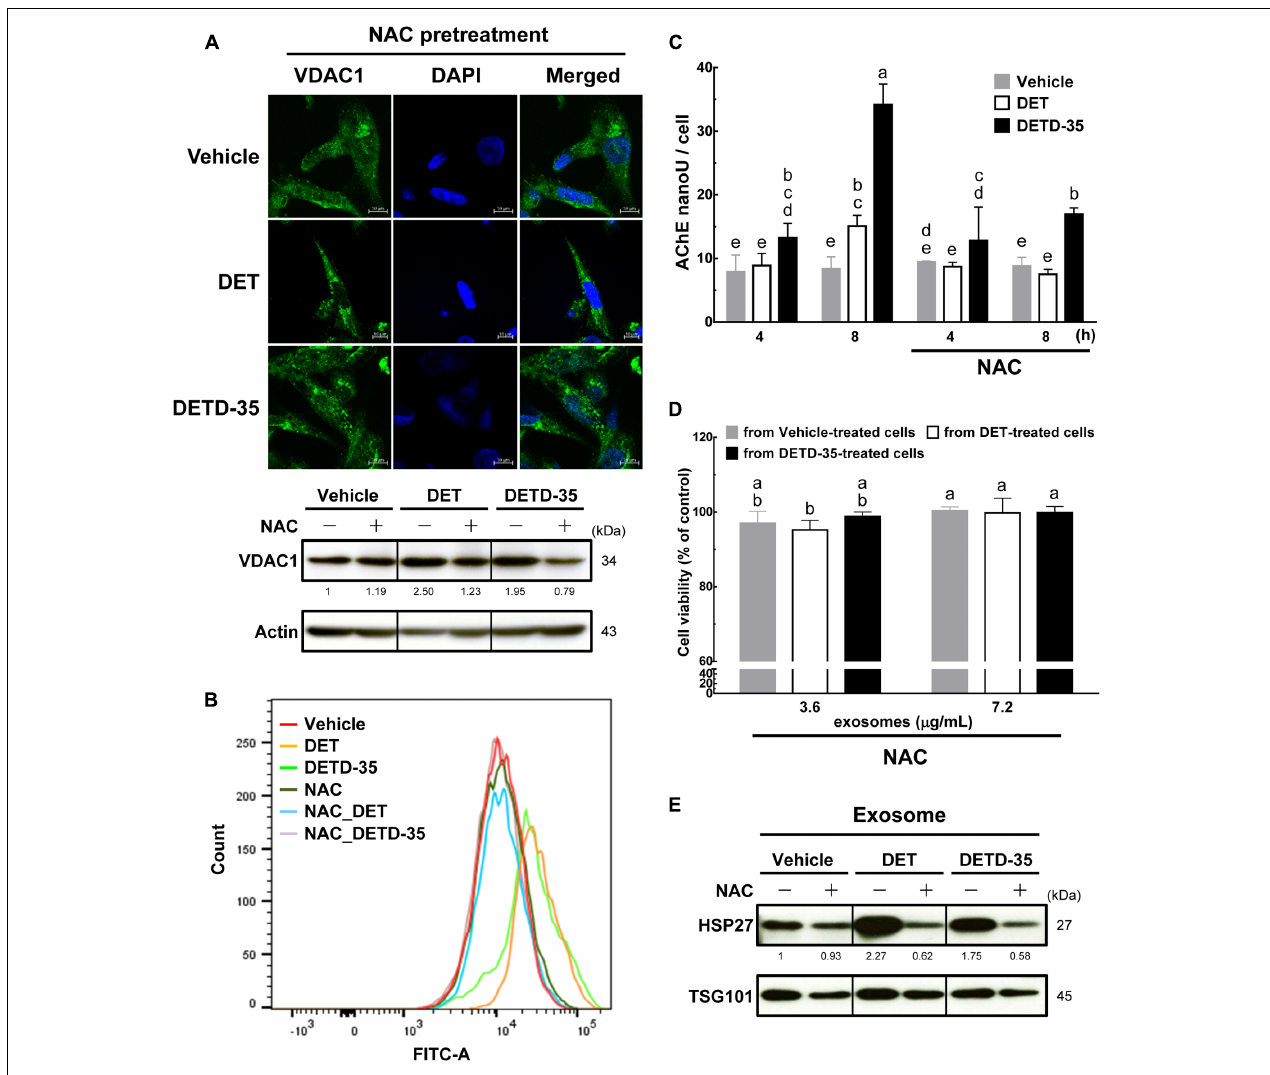
FIGURE 7 | Pretreatment with ROS scavenger NAC prevents DET and DETD-35 induced mitochondrial dysfunction and reverted exosome release from cancer cells and their cytotoxic activity. (A) Immunofluorescence confocal micrographs of MDA-MB-231 cells pre-treated with 5 mM NAC for 1 h, and then treated with the vehicle (0.5% DMSO), 11 µ M DET and 3 µ M DETD-35 for 24 h. The treated cells were fixed using 100% ice-cold methanol, and stained with VDAC1 (green) and DAPI (blue) to visualize mitochondrial structures and nuclei. Immunoblotting of VDAC1 protein in the TNBC cells were pre-treated with 5 mM NAC for 1 h, and then treated with vehicle or compounds for 12 h. β -actin was used as a loading control. (B) MDA-MB-231 cells were pre-treated with 5 mM NAC for 1 h, and then treated with vehicle or either compound at the same concentration for 2 h. Cytosolic free calcium level in cancer cells was determined using Fluo-4 Ca 2 + fluorescent dye using flow cytometry. (C) TNBC cells were pre-treated with 5 mM NAC for 1 h, and then treated with vehicle or either compound for 4 h and 8 h, and then the TNBC cell-secreted exosomes were collected from the culture media using differential centrifugation. Exosome samples were prepared by using a working